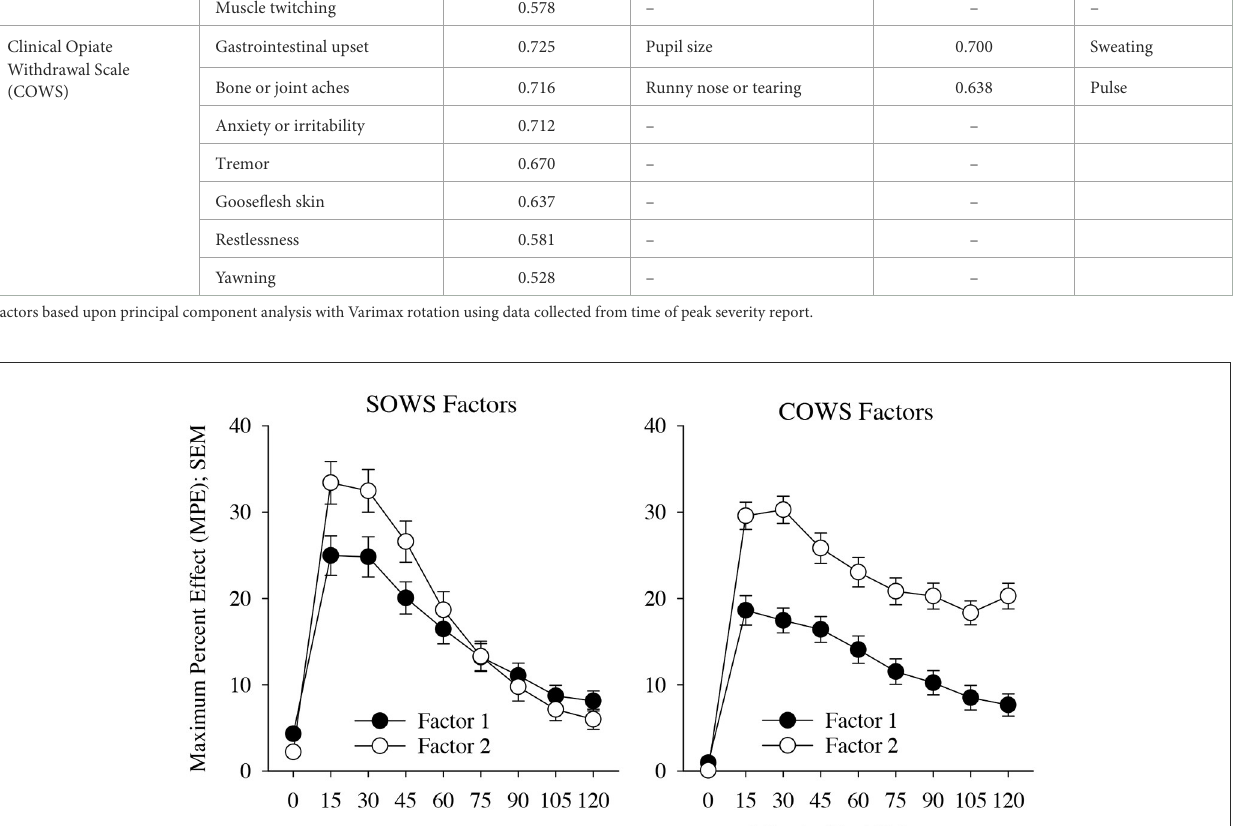
scales. Altogether this strategy should provide a method